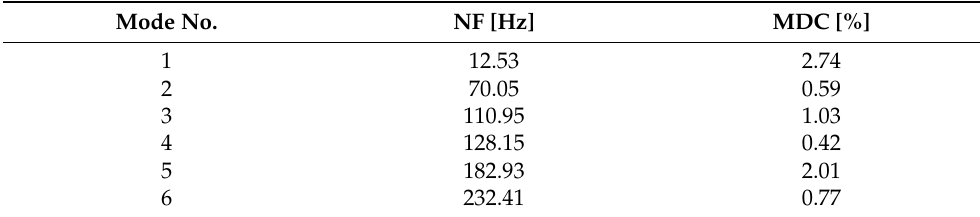
Table 1. Natural frequencies (NFs) and modal damping coefficients (MDCs) of the identified modal model.